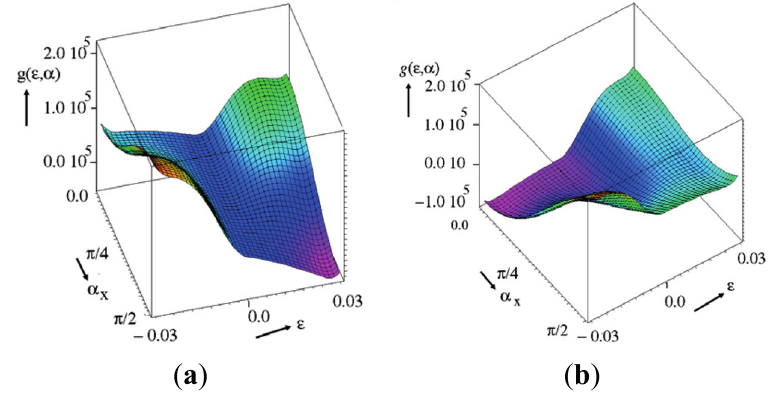
Figure 6. Schematic actuation cycle of the MSM linear actuator. ( a ) Load-free